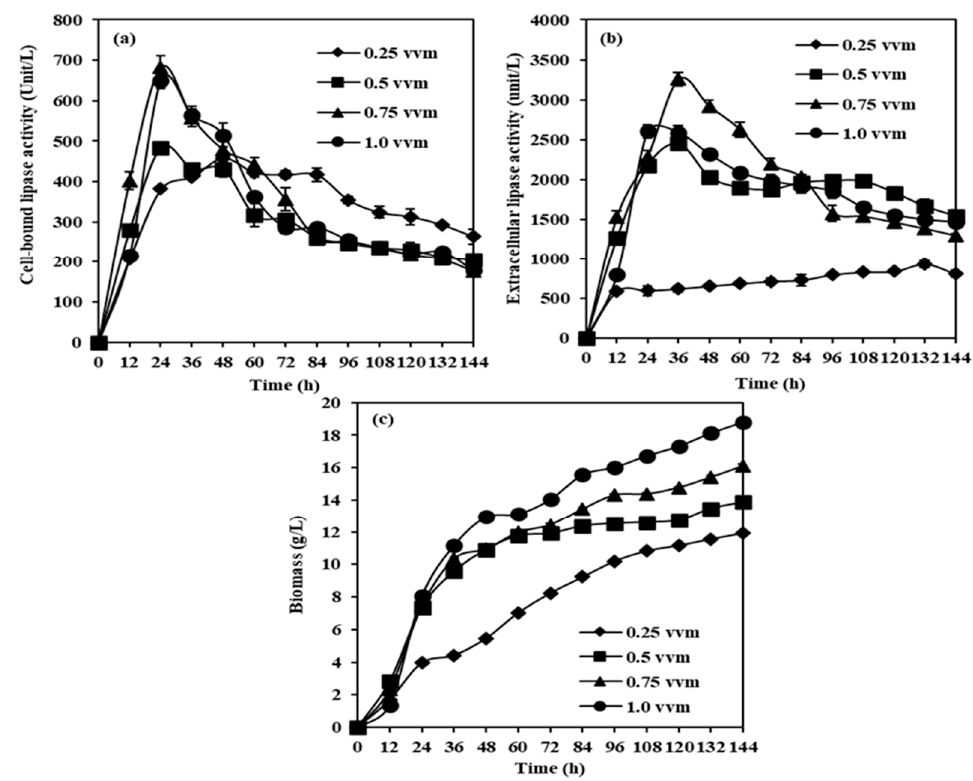
Figure 2. Effects of aeration rate on the production of CBL ( a ), extracellular lipase ( b ), and biomass ( c ) from M. spicifer SPB2 cultivated in IMY medium containing: 2% soybean oil and 0.2% Gum Arabic using inoculum level of 1 × 10 7 cell/mL at 30 ± 2 °C under agitation speed of 200 rpm.